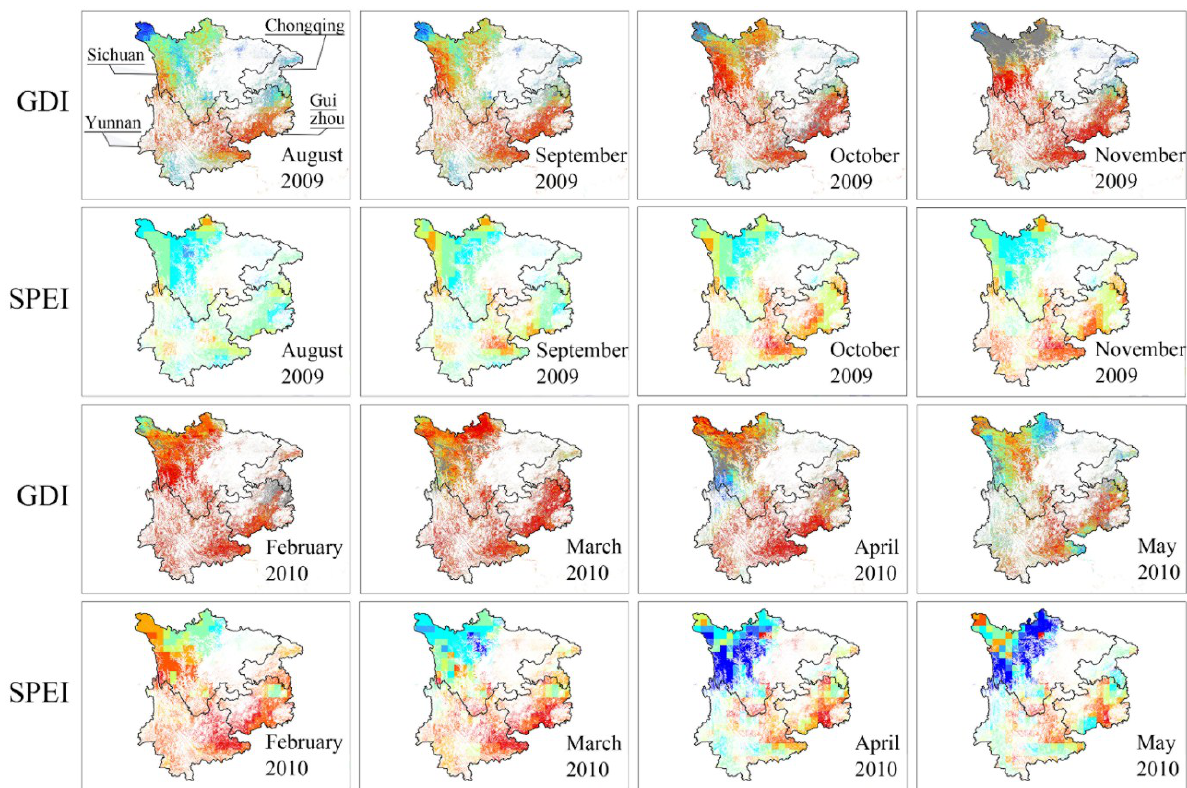
Figure 15. The performance of the global products of GDI-6CRU and SPEI-6mon in grassland regions, regarding the drought event in 2010, Southwest China. The classification scheme of GDI-6CRU and SPEI SPEI-6mon are same with the scheme adopted in Figures